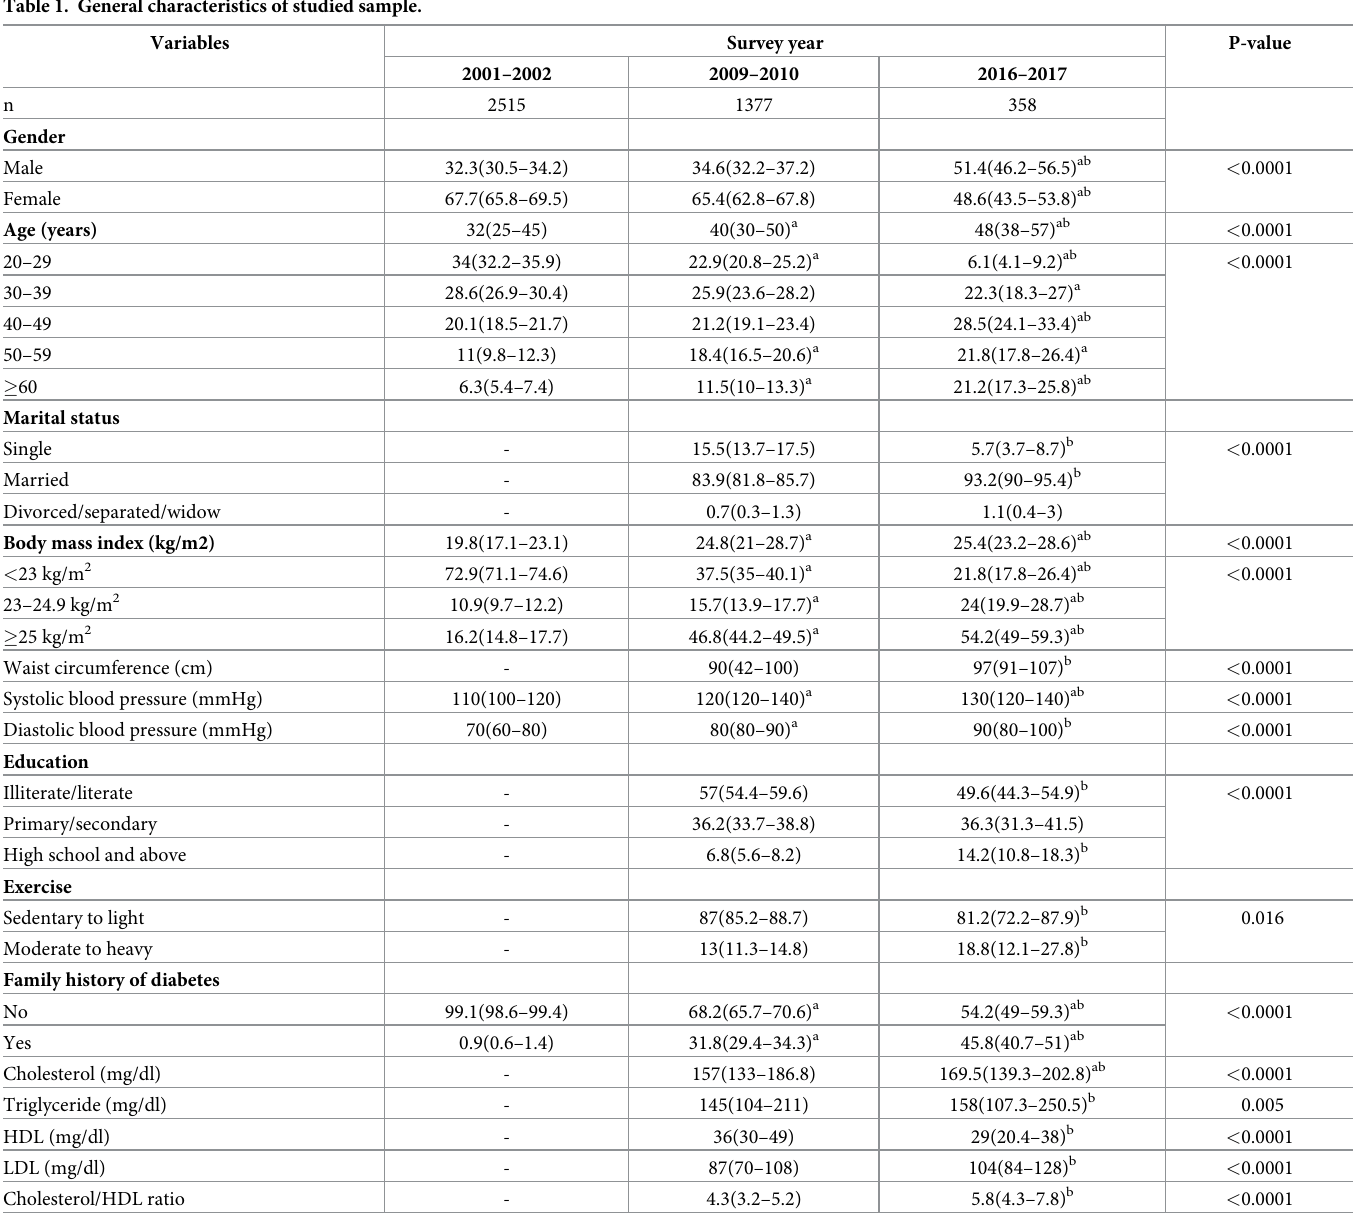
Table 1. General characteristics of studied